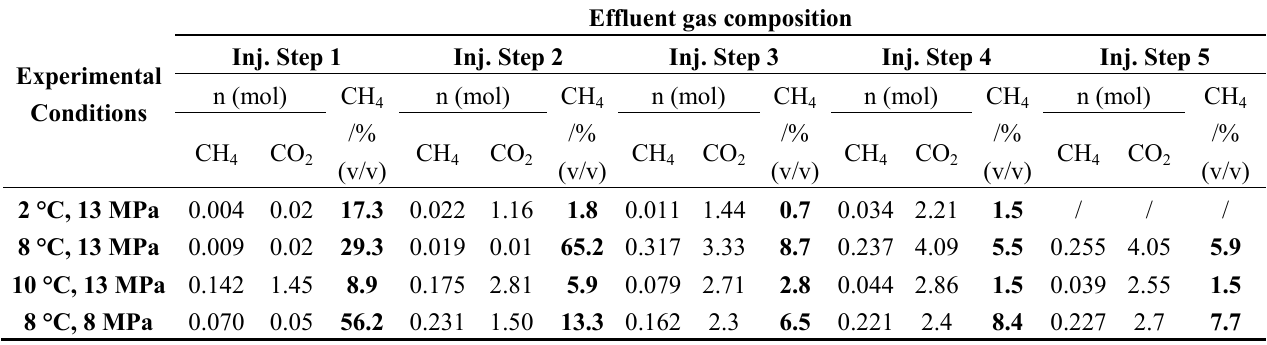
and CO . Amounts of CH 4 2